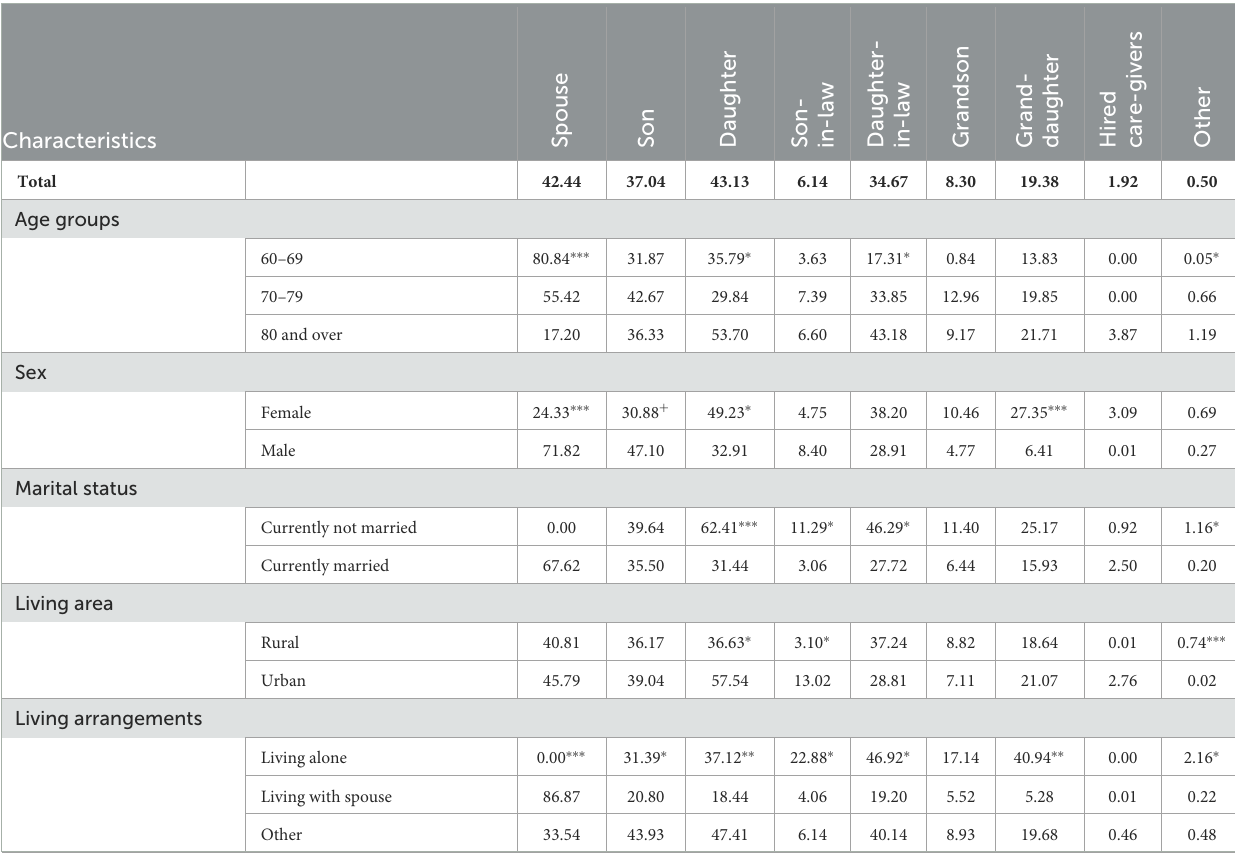
TABLE 3 Comparison between older groups by their characteristics on proportions of receiving care from various care-givers.